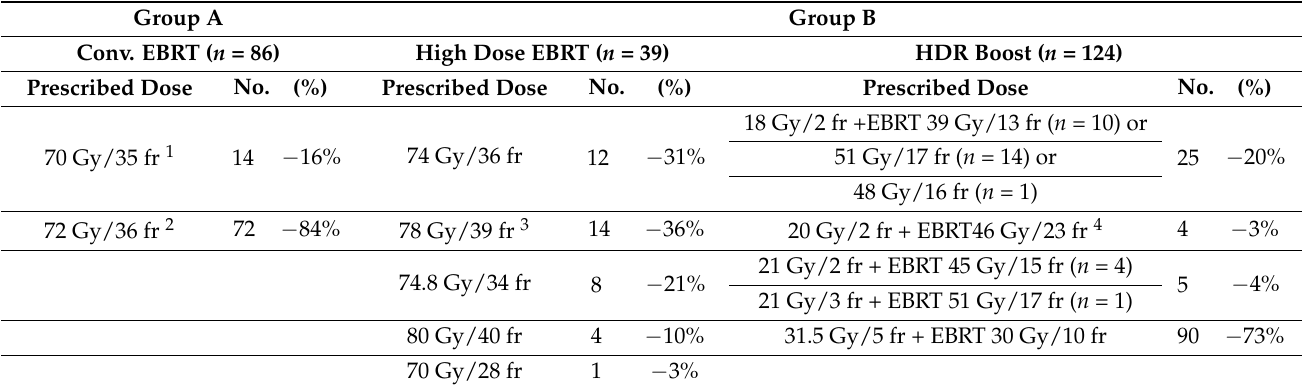
Table 2. Treatment schedule.